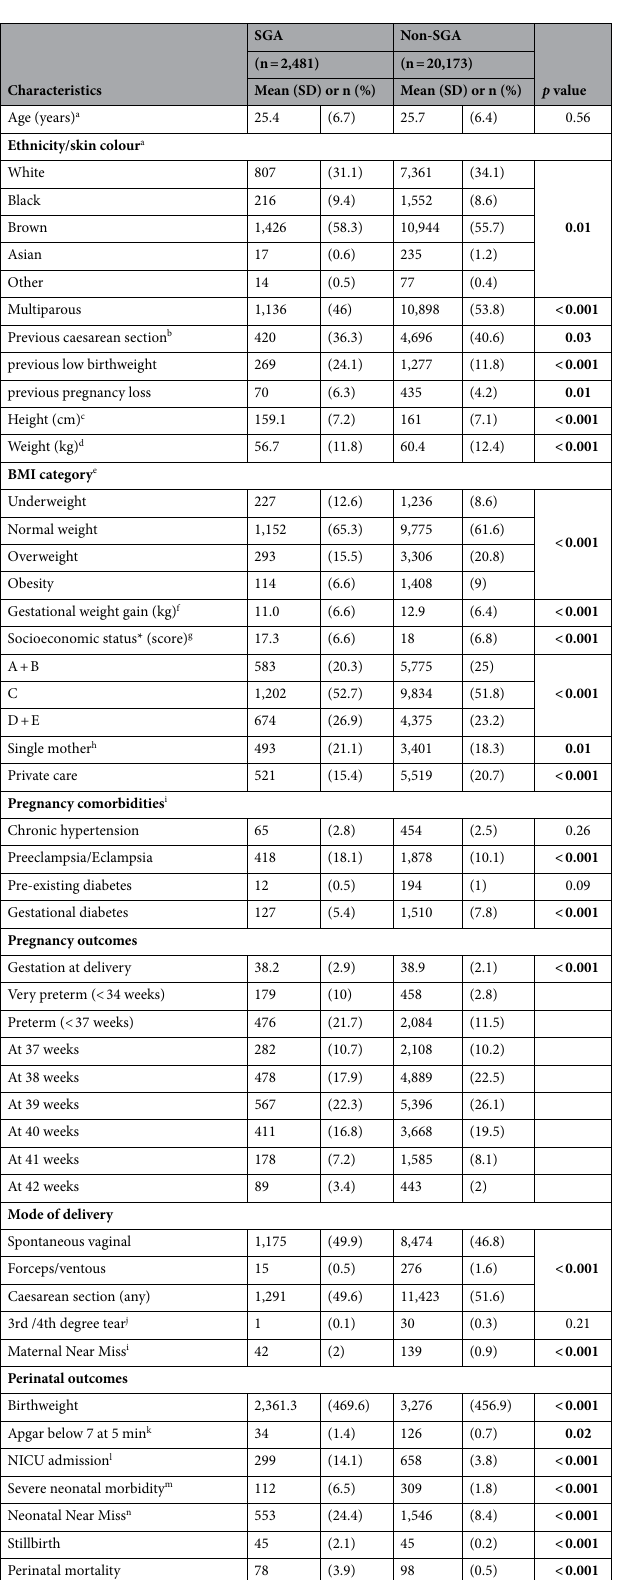
Table 1. Demographic characteristics, maternal and perinatal outcomes. BMI: body mass index; NICU, neonatal intensive care unit; SD, standard deviation; SGA, small for gestational age. p values in bold are statistically significant. Missing information for a 5; b 62; c 4,674; d 1,219; e 5,143; f 1,760; g 211; h 12; i 23; j 13,630; k 882; l 108; m 879; n 90 cases. *Socioeconomic status was reported as both continuous (score) and categorical (social